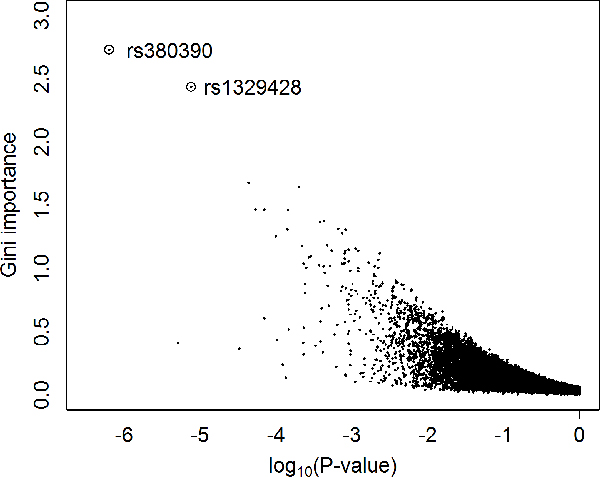
Relationship between the gini importance and the p-value for the B statistic. x-axis is the logarithm (base 10) of the p-value for the B statistic. y-axis is the gini importance.